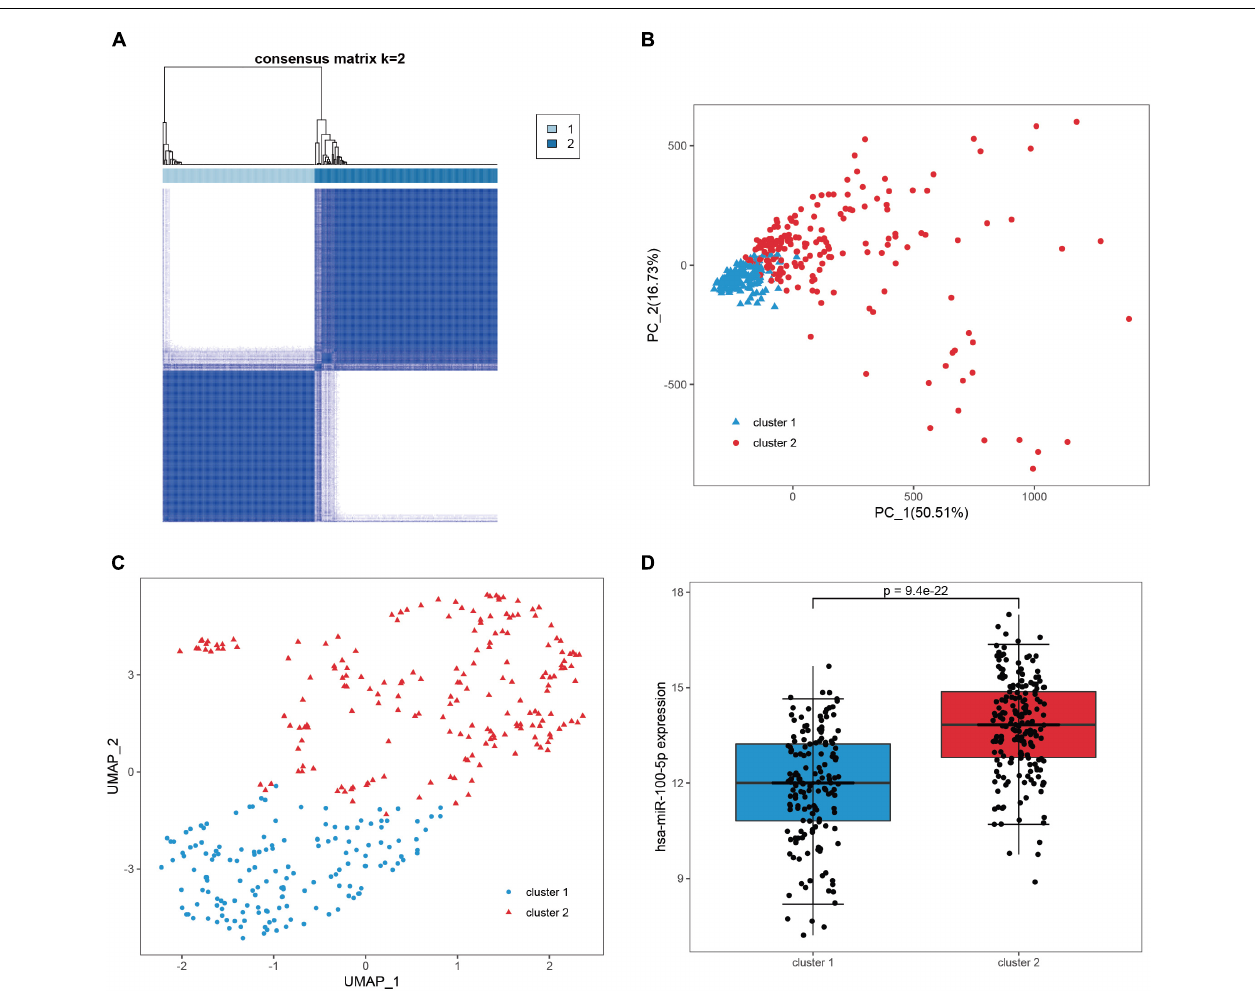
FIGURE 4 | Validation of the candidate genes as robust miR-100-5p-related genes. (A) Consensus clustering was utilized to assign 348 samples in TCGA-STAD into two clusters based on the candidate genes. (B,C) PCA analysis (B) and UMAP analysis (C) demonstrated that the two clusters showed absolute dissimilarity. (D) The expression levels of hsa-miR-100-5p were significantly different between the two clusters.